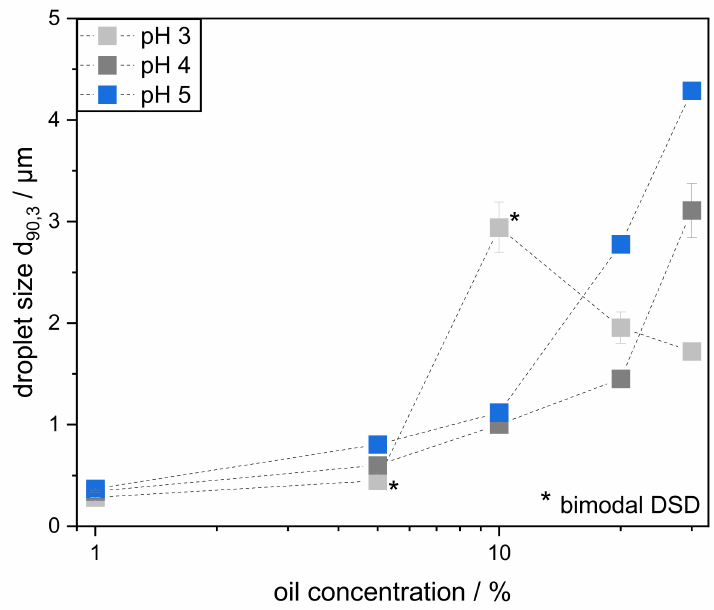
Figure 6. Characteristic droplet size d 90,3 of emulsions prepared with 0.5 wt% pectin and varying oil content (1–30 wt%) at different pH levels (3, 4, and 5). The emulsions were prepared with a high-pressure homogenizer at 400 bar and in a second pass at 800 bar. * Emulsion with bimodal droplet size distribution